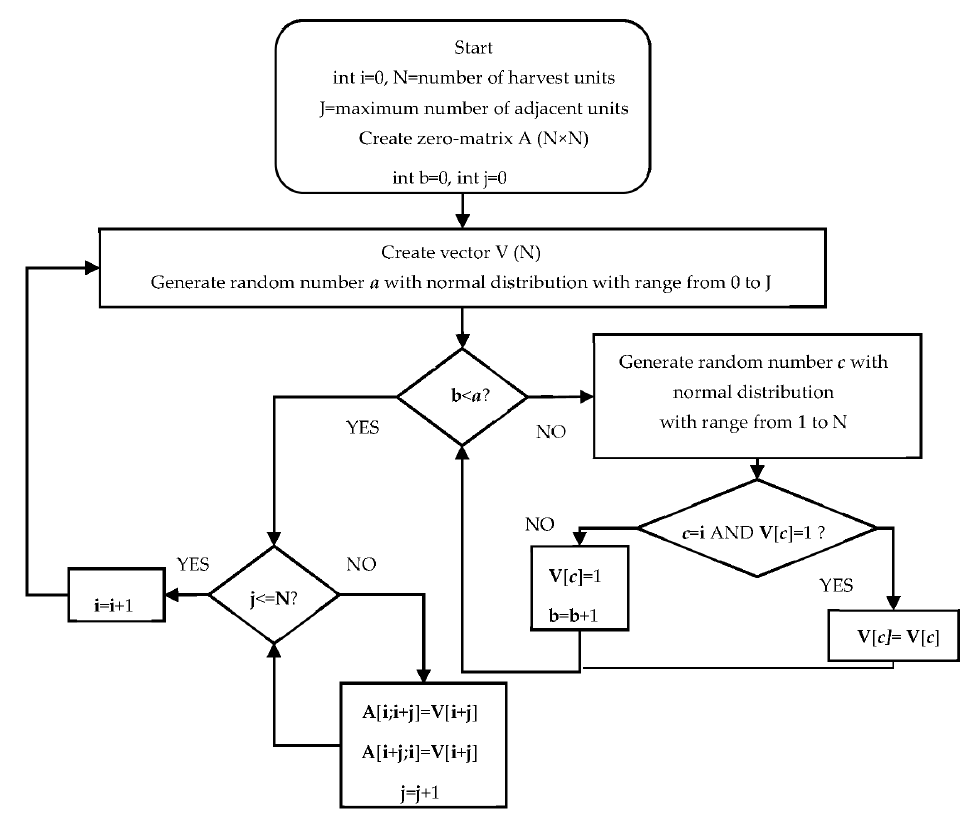
Figure 1. The process of random generation of a spatial forest structure (int = integer number).